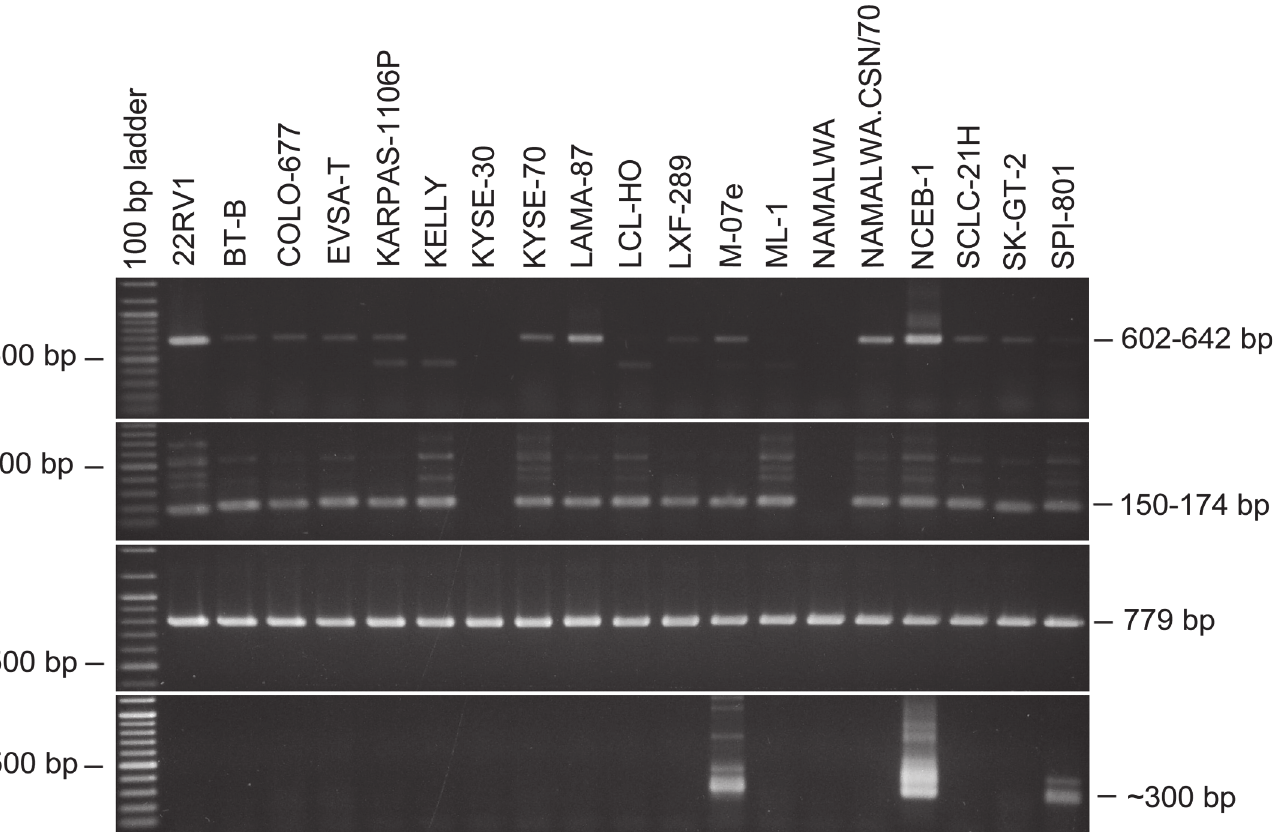
Fig 1. PCR-Assays for the sensitive and reliable detection of MLV sequences in cell line DNA. The upper two panels show the ethidium bromide stained gels of the MLV-specific PCR assays performed with the outer (first panel) and inner primers (second panel). The sizes of the MLV-specific bands are 604 – 642 bp and 150 – 174 bp, respectively, depending on the MLV genotype. Some cell lines produce an unspecific band with the outer primers (also seen in some MLV-negative cell lines). The inner primers usually also produce several unspecific bands seen only in MLV-positive cell lines. The cell lines KYSE-30 and NAMALWA are MLV-negative in the assay, whereas the cell lines from the same series or subclones are MLV-positive, respectively. The third panel demonstrates the integrity of the DNAs used for the analyses by amplification of the human ABL gene. The lower panel shows contamination of the genomic DNA with mouse DNA by amplification of mouse specific IAP coding sequences. The PCR produces a double band of approximately 300 bp. The cell line NCEB-1 harbors several mouse-derived chromosomes.